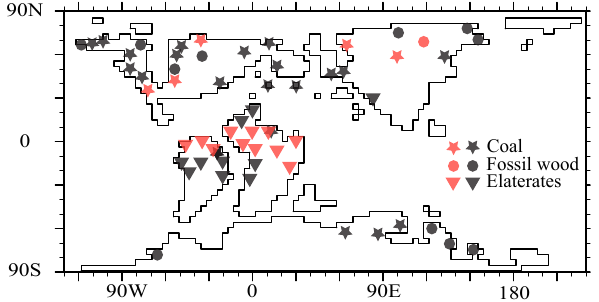
Fig. 3. Distribution of mid-Cretaceous vegetation inferred from fos- sil wood, pollen of Elaterate assemblages and coal deposits and comparison with simulated vegetation. Fossil wood (solid circle) and coal deposits (solid star) are indicators of high-productivity forests; fossil pollen of Elaterates assemblages (down triangle) in- dicates dry climate and/or mangrove swamps and savannah (Dino et al., 1999; Ziegler et al., 2003). Paleofloral data is adapted from Beerling et al. (1999), Dino et al. (1999), Falcon-Lang et al. (2001), Herman and Spicer (1996) and Price et al. (1997). The shading of symbols shows agreement between the simulated vegetation in the 10xDGVM experiment and paleofaunal data. Black indicates that the model simulates the observed faunal type; red indicates that it does not. The model-data comparison (not shown) is nearly identical for the 16xDGVM